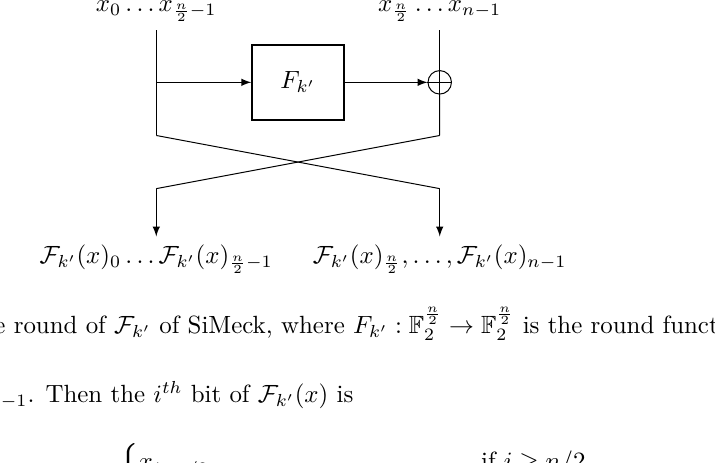
Figure 4: One round of F k 0 of SiMeck, where F k 0 : F